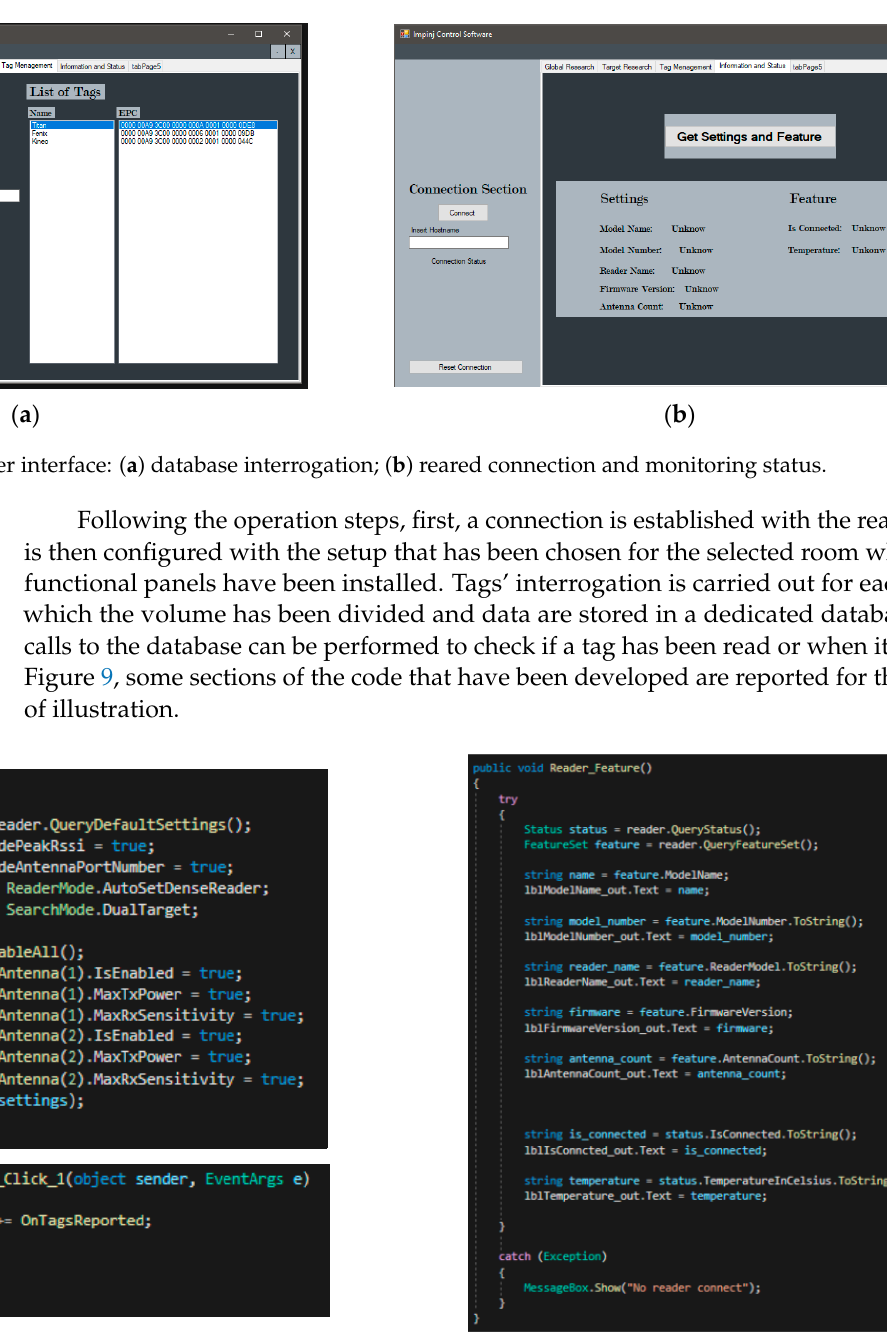
Figure 9. Software details and examples of code sections.